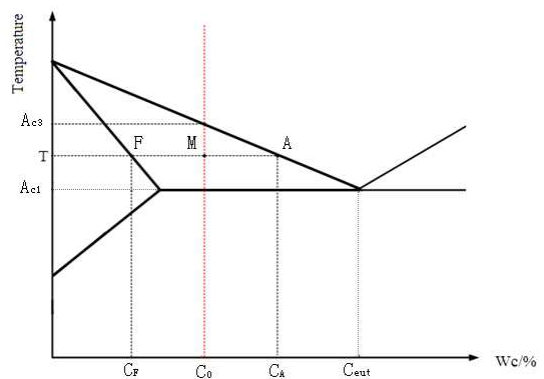
Table 5. Carbon content in austenite at different temperatures in the two-phase region.